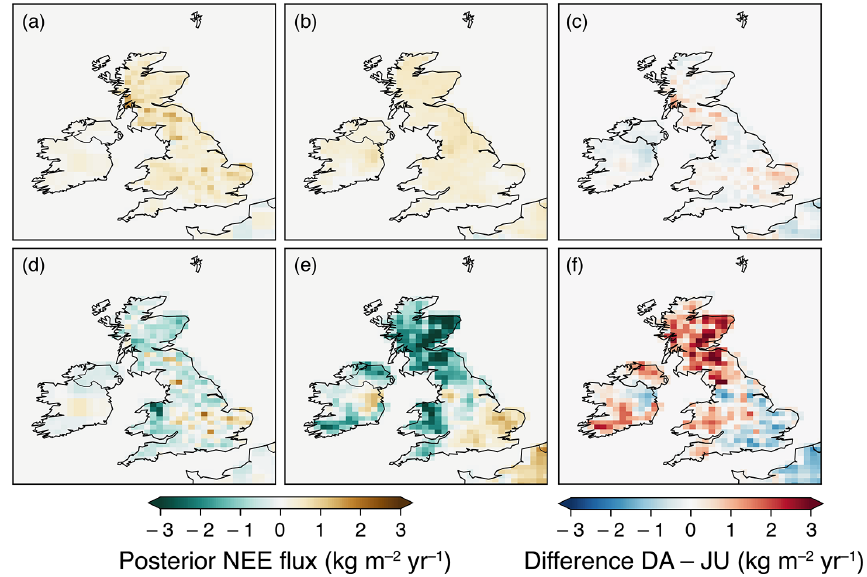
Figure 6. Posterior net biospheric (NEE) flux maps averaged over winter 2013 (December 2013, January–February 2014) and summer 2014 (June–August 2014). (a) Winter NEE flux from DALEC inversion. (b) Winter NEE flux from JULES inversion. (c) Difference between winter NEE flux from DALEC (DA) and JULES (JU) inversions. (d) Summer NEE flux from DALEC inversion. (e) Summer NEE flux from JULES inversion. (f) Difference between summer NEE flux from DALEC (DA) and JULES (JU)